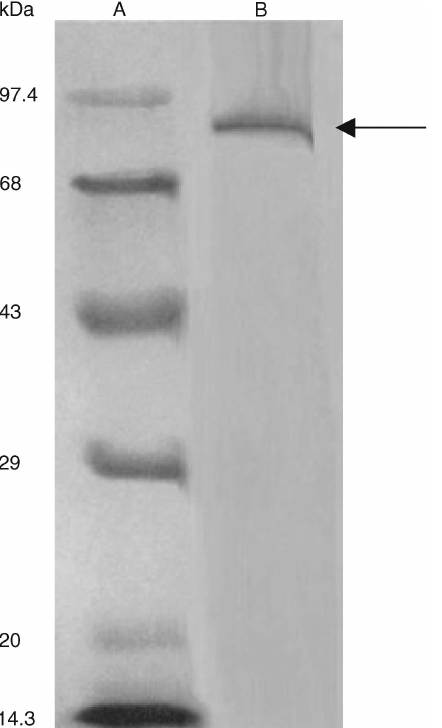
Figure 1. The sodiumdodecyl sulfate polyacrylamidegel electrophor- esis of the purified protease from Halogeometricum borinquense strain TSS101. Lane A shows relative molecular mass standards: phosphorylase b (97.4 kDa); bovine serum albumin-(68 kDa); oval- bumin (43 kDa); carbonic anhydrase (29 kDa); soyabean trypsin in- hibitor(20 kDa); and lysozyme (14.3 kDa). Lane B shows the purified protease (86 kDa, indicated by arrow).